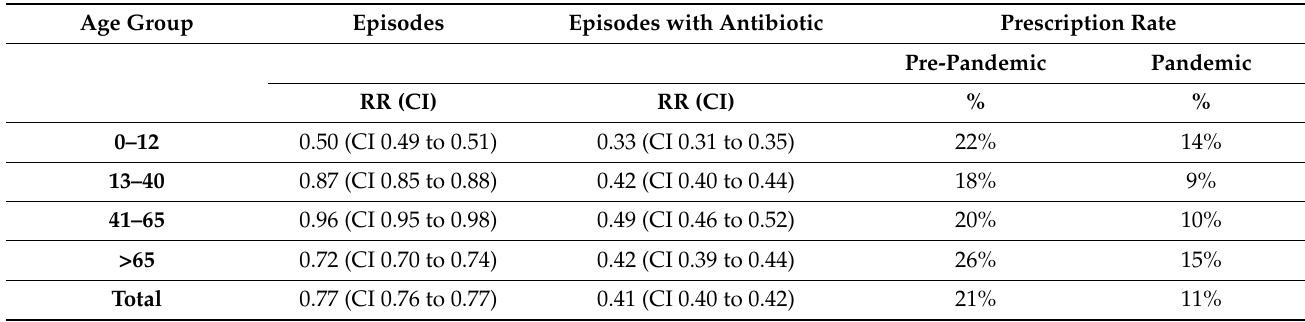
Table 3. Relative risks of respiratory/ear infection episodes (total and with antibiotic prescription) and prescription rates pre-pandemic and during the first pandemic year, per age category.